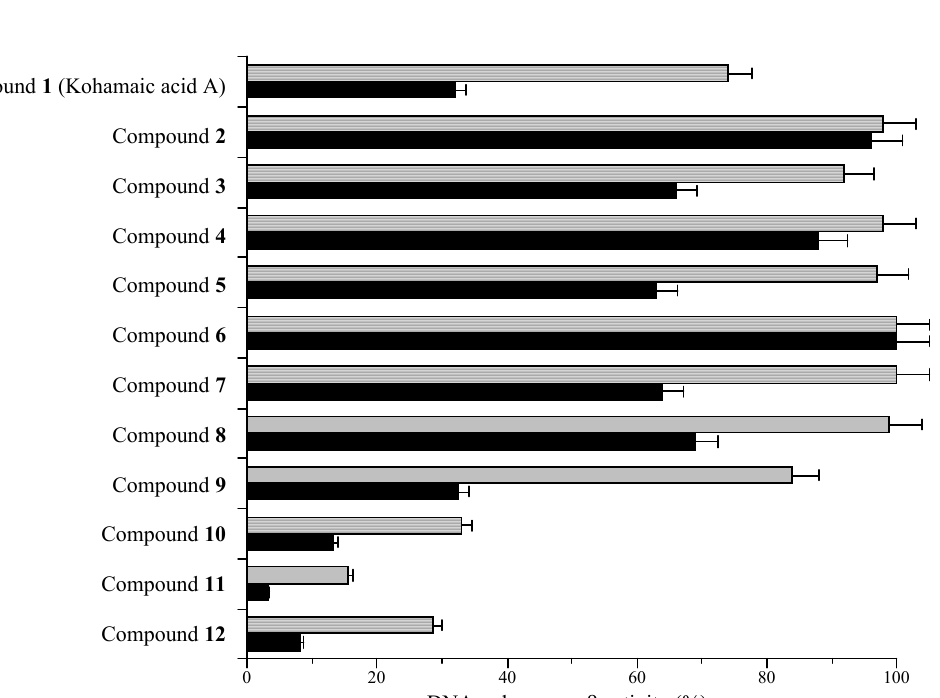
DNA polymerase β activity